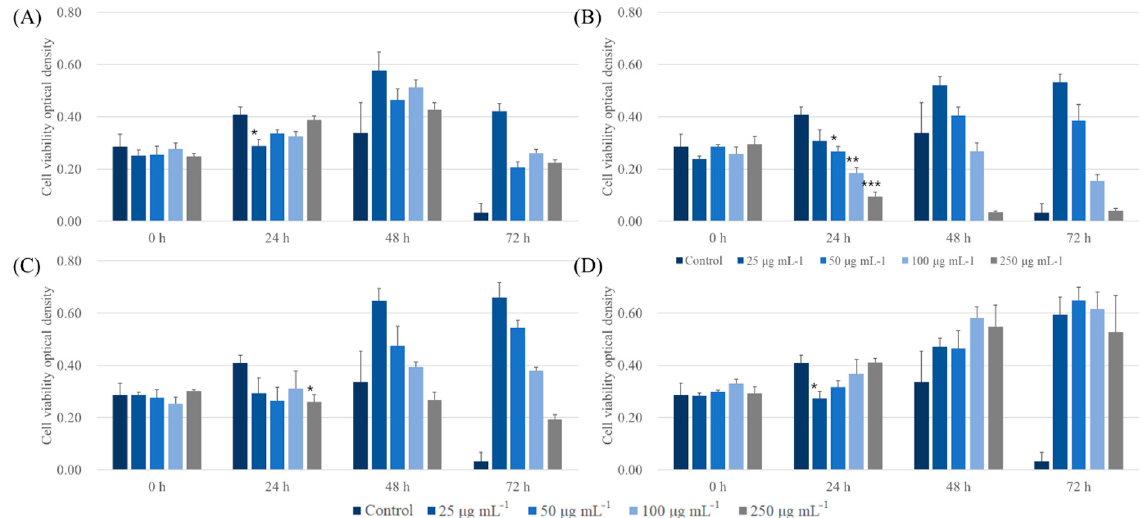
Figure 5. Cytotoxic effect of ALNPs on A549 cells determined by the Cell Counting Kit-8 assay. ( A ) ALNP-C4, ( B ) FALNP1, ( C ) FALNP2, and ( D ) FALNP3. All data sets were compared to the blank control (serum-free DMEM containing 1% of antibiotic–antimycotic solution). The levels of significant differences were set at probabilities of * p < 0.05, ** p < 0.01, and *** p < 0.001.